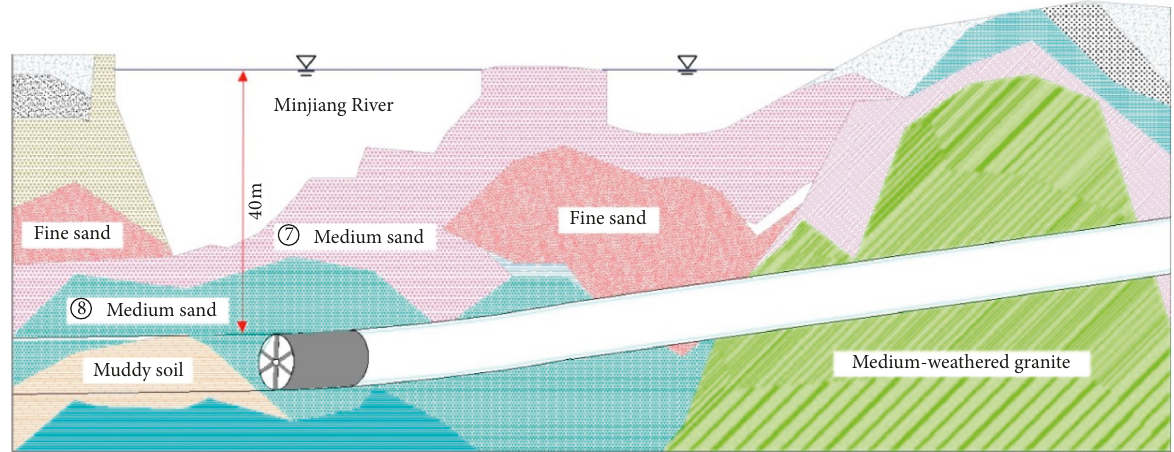
Figure 2: Geological diagram of the section under the